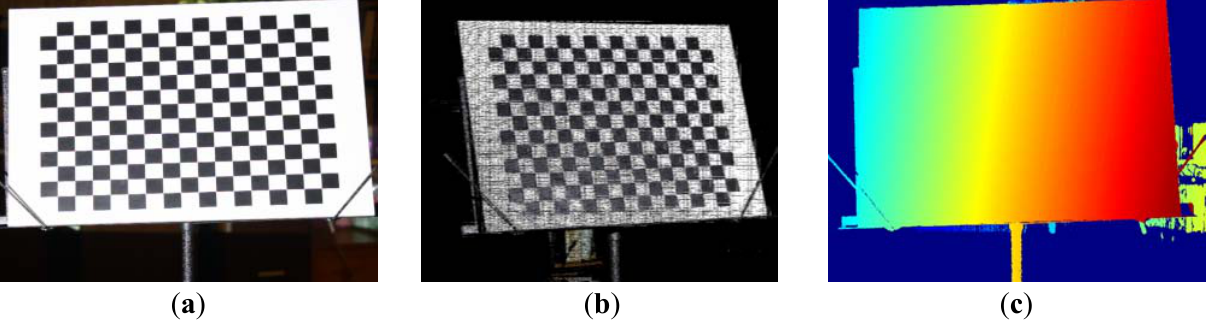
Figure 1. ( a ) A chessboard commonly used to calibration an image sensor. ( b ) Dense reconstruction of the projector’s view. ( c ) Visualization of camera-projector x -coordinate correspondences acquired using seven Gray-coded patterns and eight phase-shifting